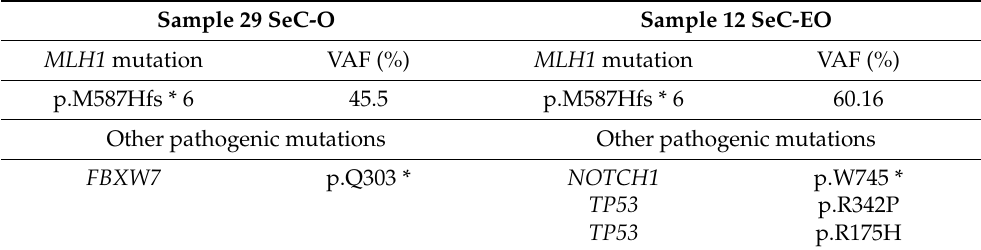
Table 4. Mutations in suspected Muir–Torre syndrome